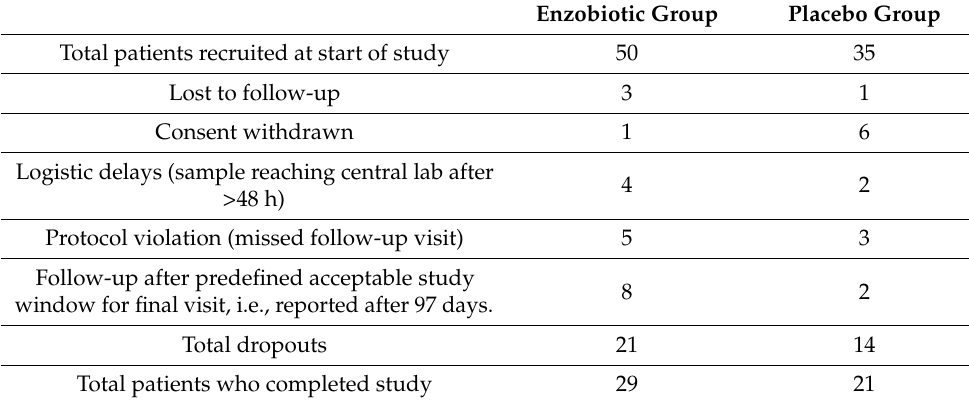
Table 1. Study recruitment and attrition